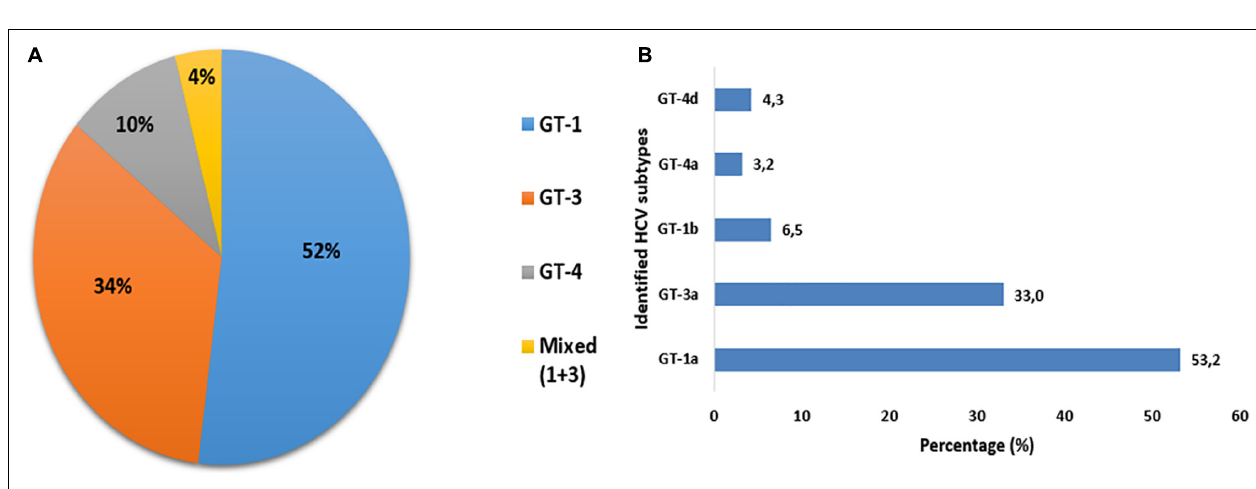
FIGURE 2 | Phylogenetic tree of HCV genotypes identified among HCV-positive PWID attending an SSP in North Eastern region of Tunisia in comparison with 45 reference strains. The tree was performed using the maximum likelihood method and the kimura-2 parameter model. Topology was supported by 1,000 bootstrap replicates. Bootstrap values lower than 50 were not indicated. The sequences reported in this study were identified by the accession numbers.